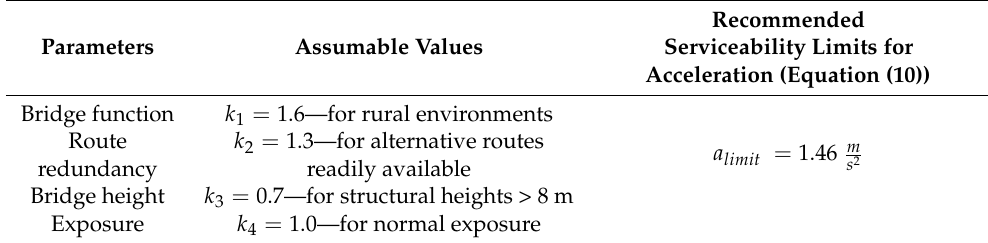
Table 6. The Aberfeldy footbridge serviceability limits for vertical acceleration, based on the UK National Annex to Eurocode 1 [43].